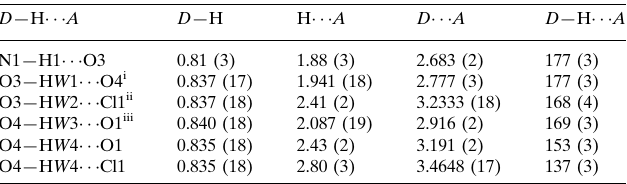
Hydrogen-bond geometry (A˚ , (cid:2)